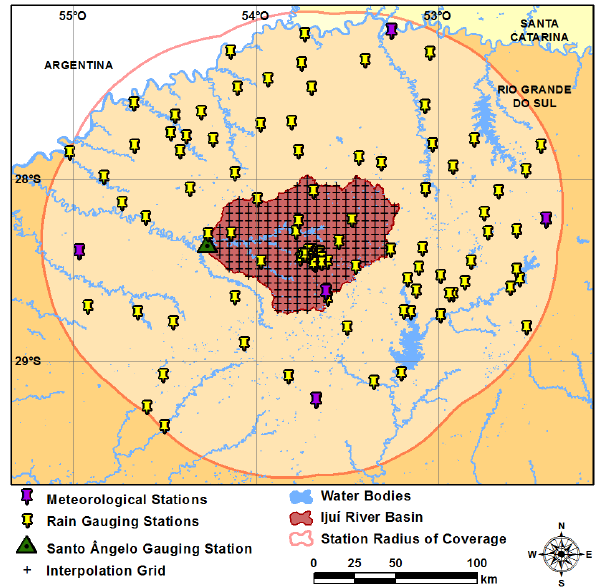
Figure 2. Location of the stations with hydrologic and climate data used in a radius of coverage of 100km in relation to the Ijuí River